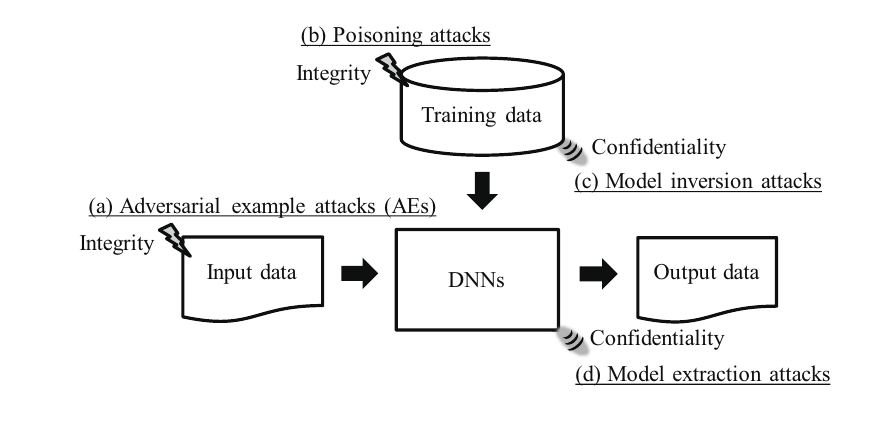
Figure 18: Taxonomy of attacks against